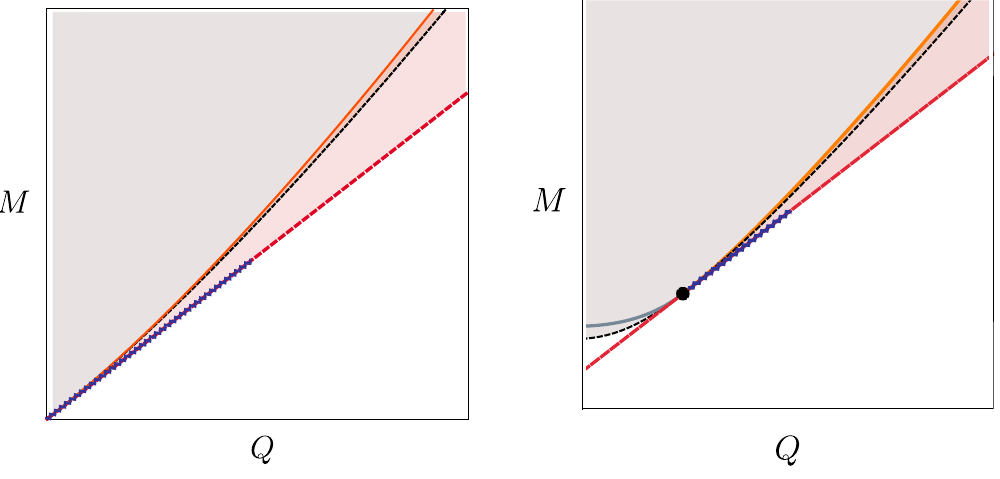
Figure 1 . Left: microcanonical phase diagram of charged, non-rotating hairy black holes [13, 27]. The Reissner-Nordstr(cid:127)om black holes exist above their extremal limit (black dashed line), and the hairy black holes exist below the bold orange line, which shows the onset of the superradiant instability. These solutions extend down to the BPS bound, where they reduce to the smooth soliton (the purple wavy line) in the limit T ! 0, while keeping the value of the scalar (cid:12)eld at the horizon " H (cid:12)xed. Right: microcanonical phase diagram of charged, rotating hairy black holes at a constant angular momentum J . The hairy black holes exist between the merger line (orange) and the BPS bound (dashed red), in the region shaded in light red. The black disk is the supersymmetric Gutowski-Reall black hole [22], which lies at the intersection of the extremal and the BPS planes. The purple wavy line shows a line of the conjectured supersymmetric hairy black holes, which terminates at a (cid:12)nite charge Q max ( J ), where the black holes become